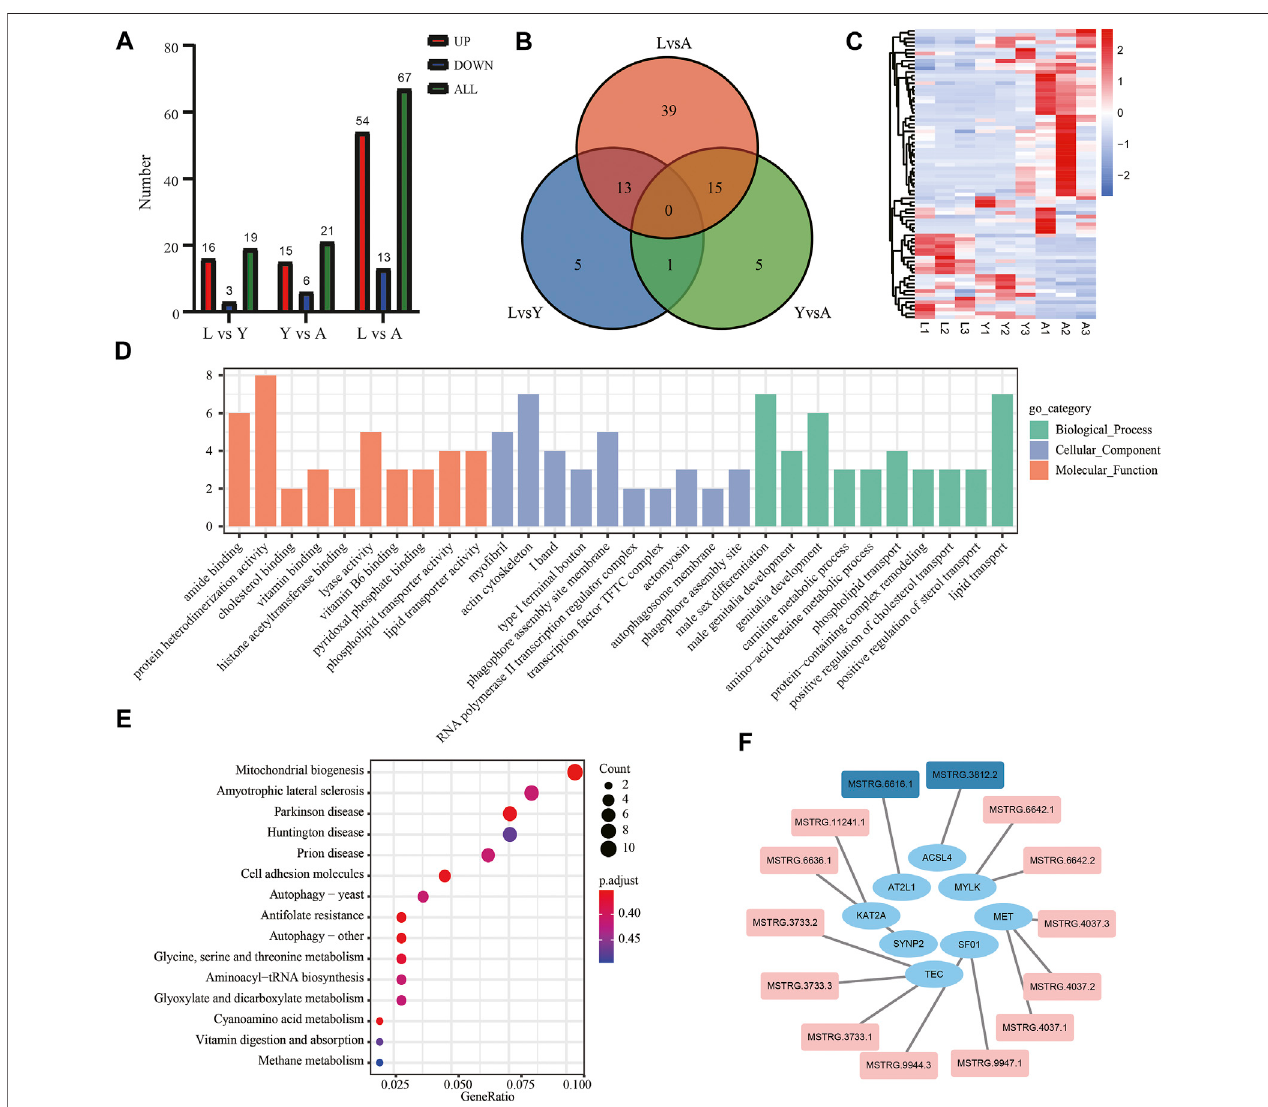
FIGURE 7 | Screening and enrichment analysis of DElncRNAs in H. manillensis during different growth periods. (A) DElncRNAs statistics of different growth periods; (B) VennplotofDElncRNAs; (C) DElncRNAclusteranalysis; (D) GOenrichmentgraphshowstheGOanalysisofthetargetgeneofDElncRNAspredictedby cis ; (E) KEGG analysis was used to uncover the role of DElncRNA target gene predicted by cis ; (F) lncRNA target genes predicted by cis (red indicates DElncRNAs).